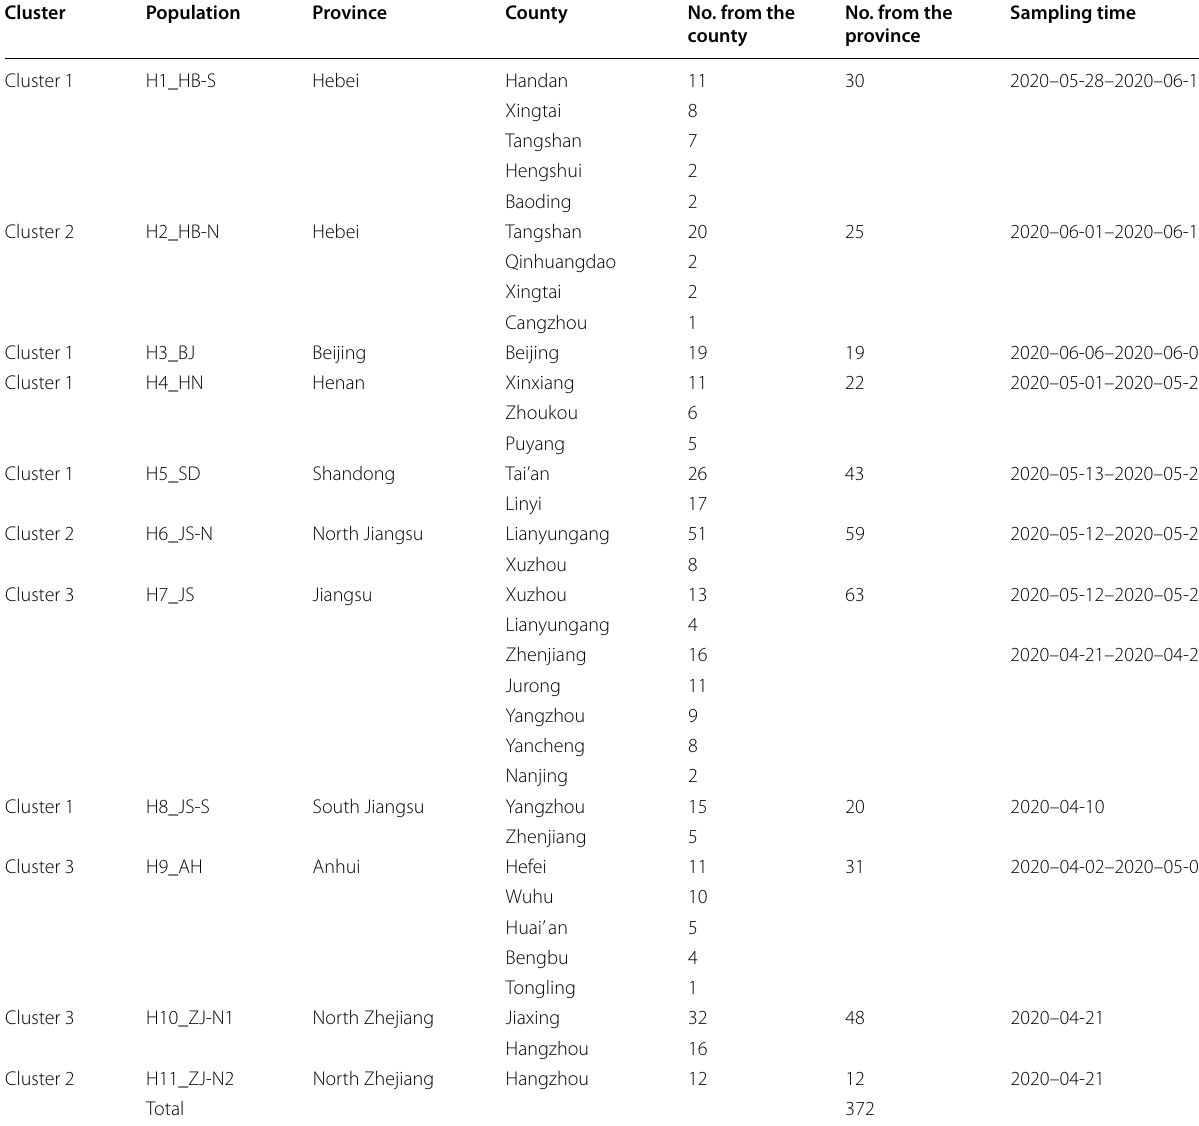
The 11 populations are intending to distribute from north to south by province